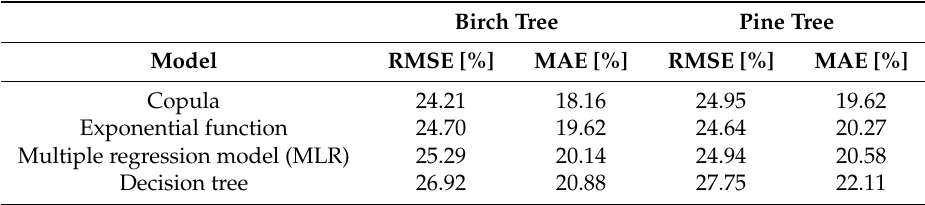
Table 4. Performance criteria results (root mean square error (RMSE) and mean absolute error (MAE)) for the different tested models (random sampling ( n = 20, training set 75%, test set 25%) was used to calculate the results for birch and pine